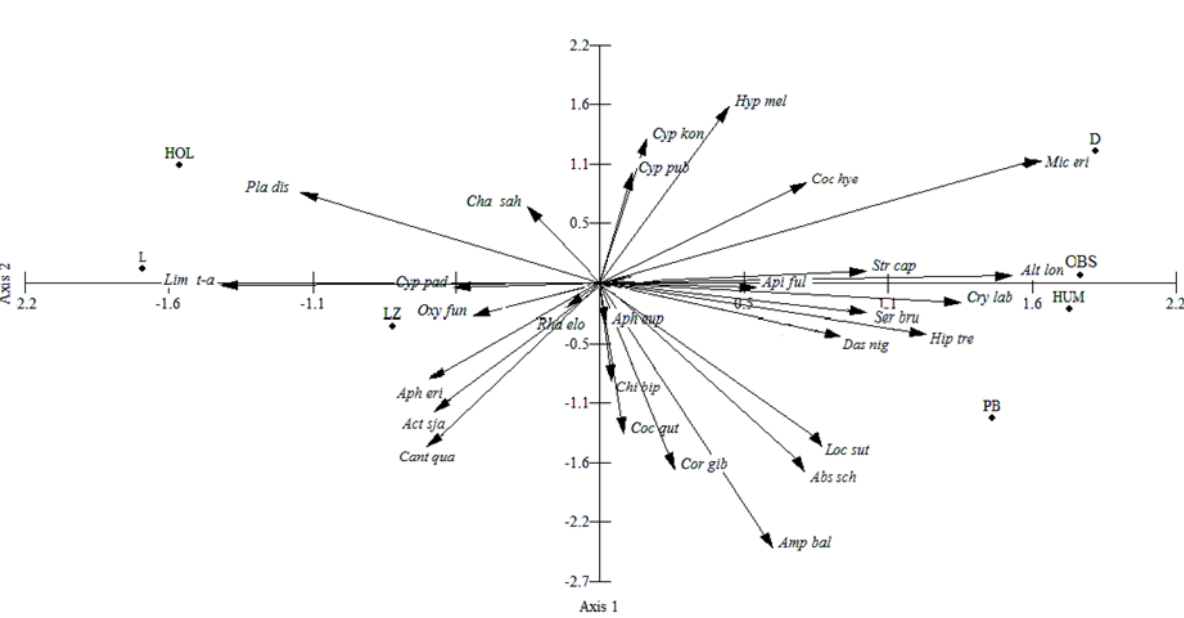
Figure 7. Odination diagram of the principal component analysis (PCA) for assemblages of Coleoptera in the habitats investigated. Species abbreviations are given in Table 3. The first two axes of the PCA ordination explained 75.27 % and 8.42 % of the variation. The cumulative percentage of variance explained by the two first axes was 83.70